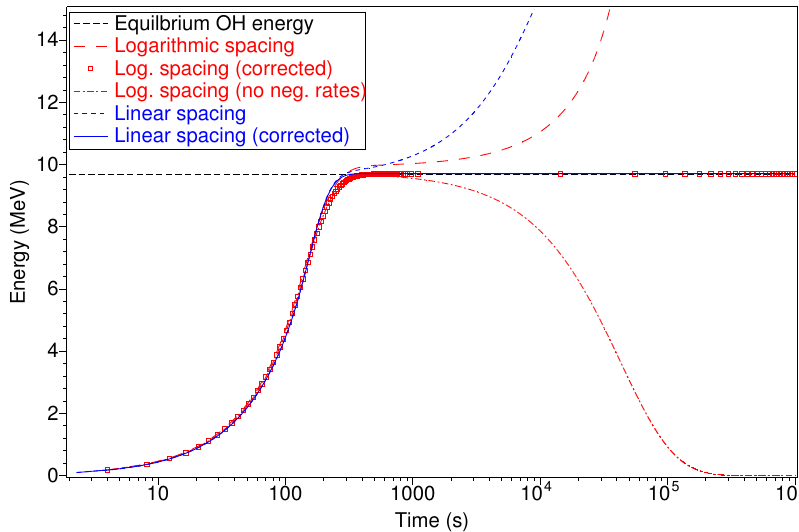
Figure 6. The calculated OH energies as a function of time are shown for logarithmic and linear distributions of 101 subranges, compared with the equilibrium value (– – –). For the linear distribution, uncorrected (- - - -) and corrected (—–) cases are shown, while for the logarithmic distribution uncorrected (— —), corrected ( (cid:3) ) and corrected with negative rates reset to zero (– · – · –) are shown.